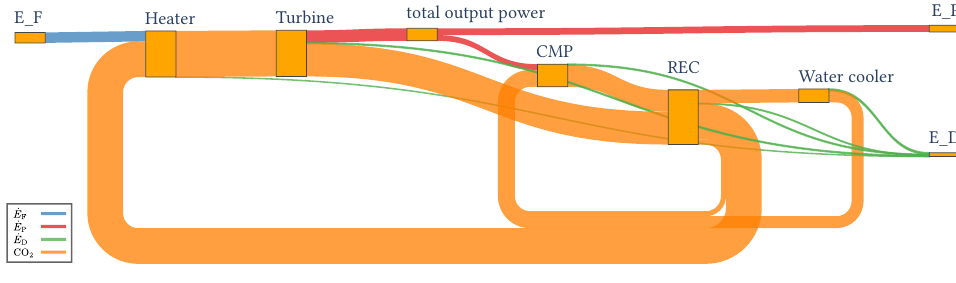
Figure 8. Machine-generated Grassmann diagram based on functional groups of sCO 2 power cycle. The value of the exergy flows are shown in a true-to-scale manner by the width of the edges.